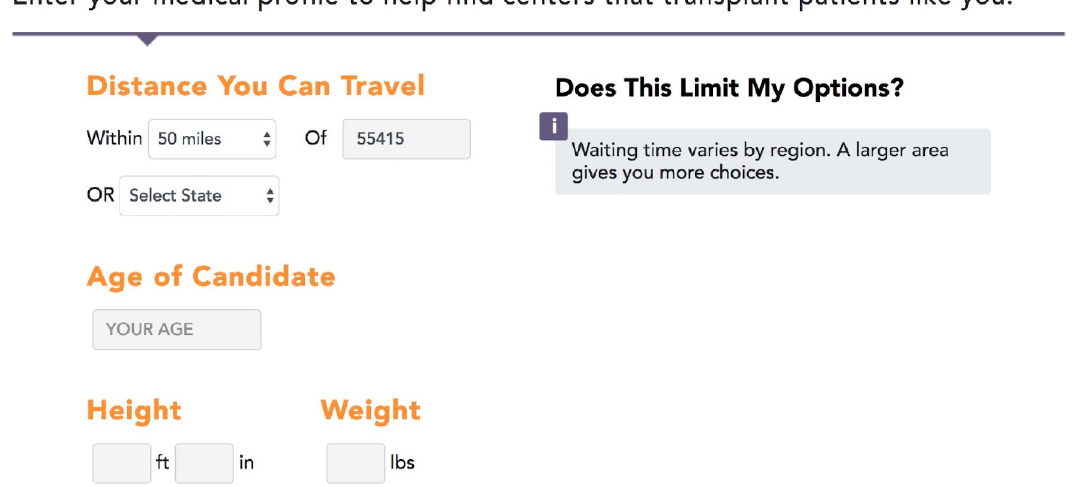
Fig 2. Development website screenshot of a portion of the data entry page: Initial iteration. The characteristics shown represent criteria that may impact if a patient is accepted or declined at a center. A pop-up message appears if a user enters data that is outside of typical criteria, such as age greater than